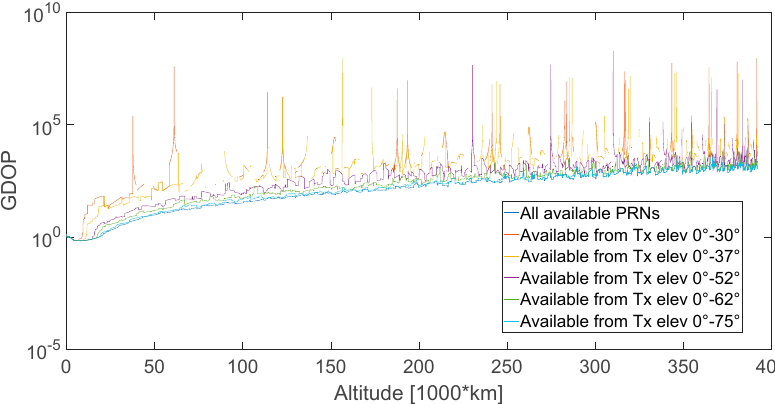
Figure 43. GDOP computed when using all the available signals (each identified by a PRN) and only the ones transmitted at angle between 0° and 30°, 0° and 37°, 0° and 52°, 0° and 62°, 0° and 75°, and 0° and 90°.